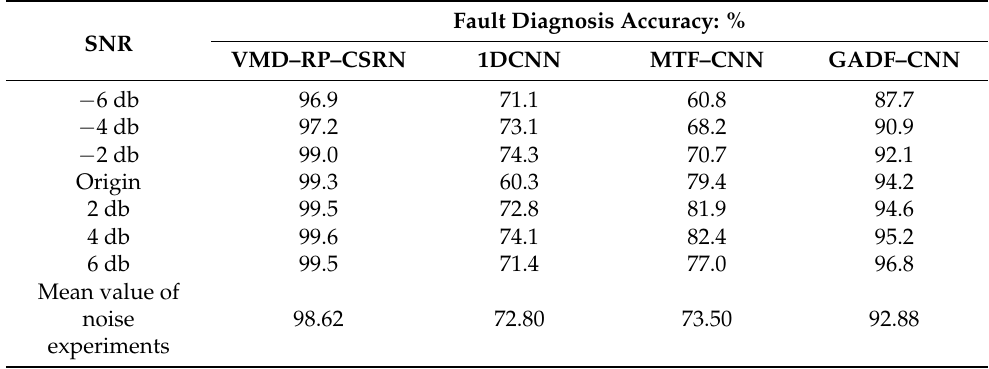
Table 7. Experimental results on the noise immunity of the model to variable speed